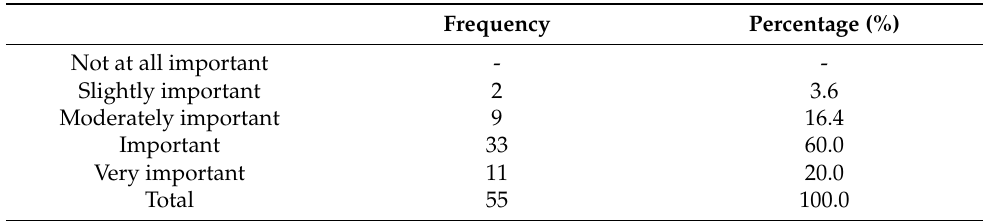
Table 2. Frequency and percentage units in relation to the importance of public access to Hub’s information ( N = 55).